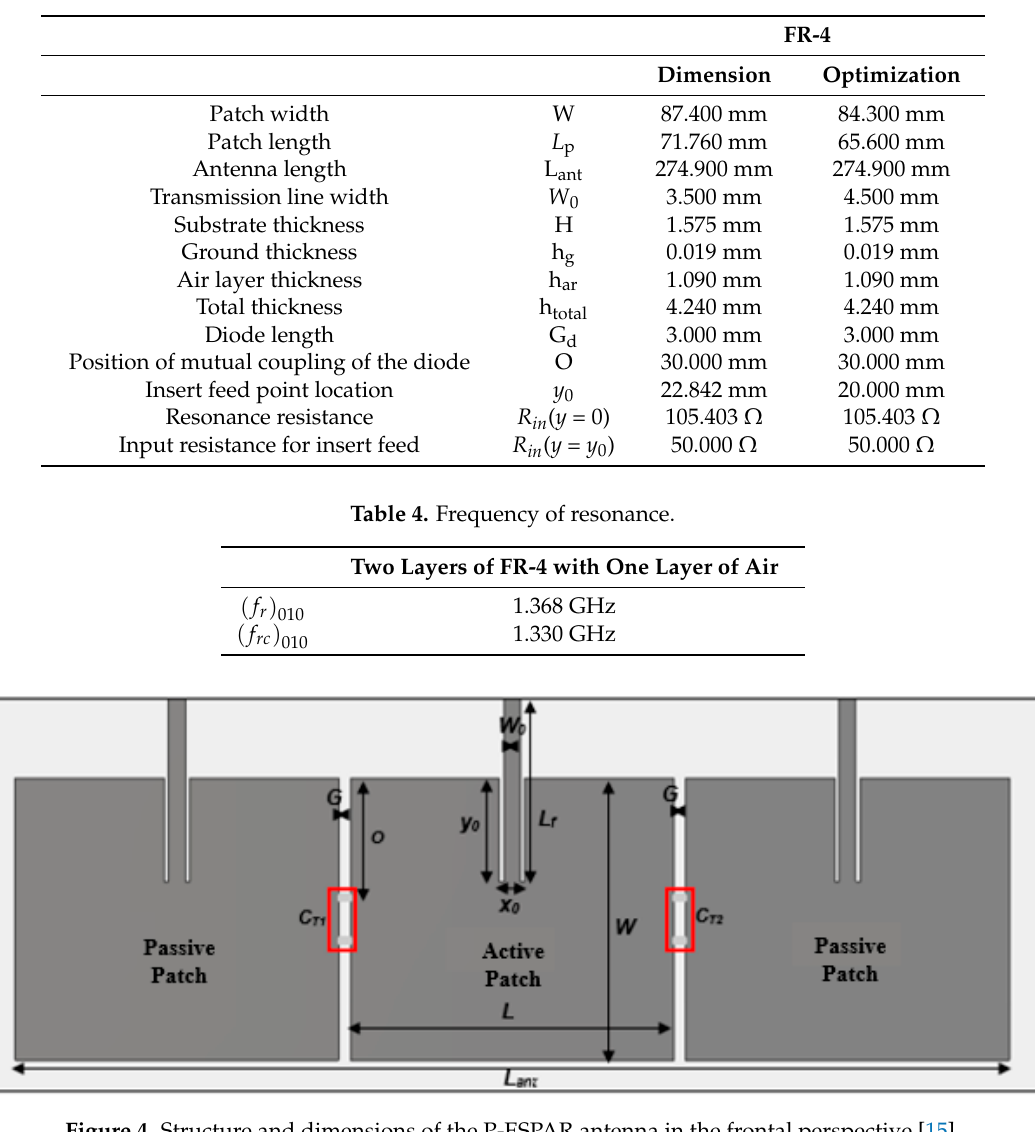
Table 3. Dimensions of the antenna with two substrate FR-4 plates and one layer of air.